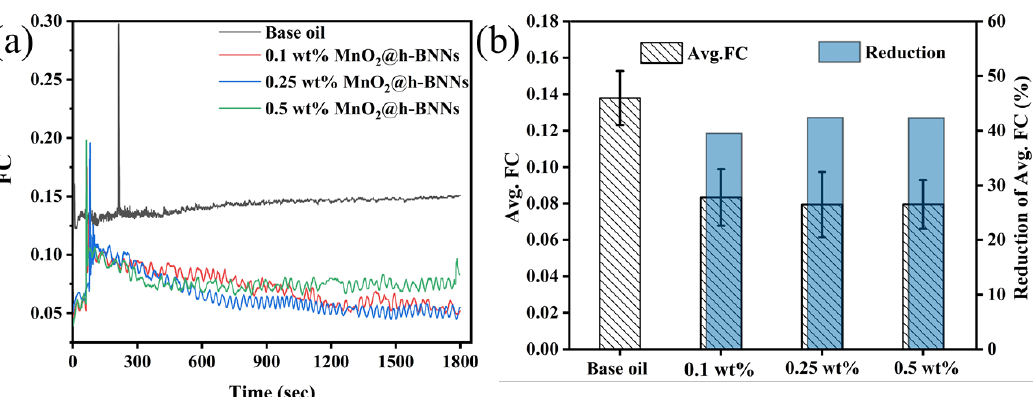
Figure 3. FC curves ( a ) and Avg. FC ( b ) for different contents of MnO 2 @h-BNNs additives.